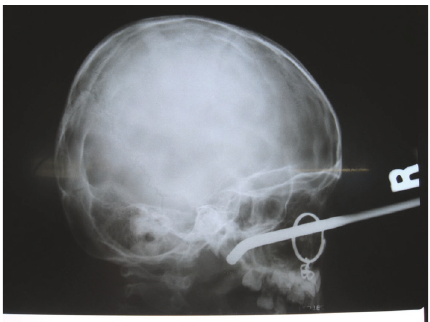
Figure 2: Preoperative X-ray of the skull lateral view, showing the Allen key in the left maxillary sinus to nasopharynx.